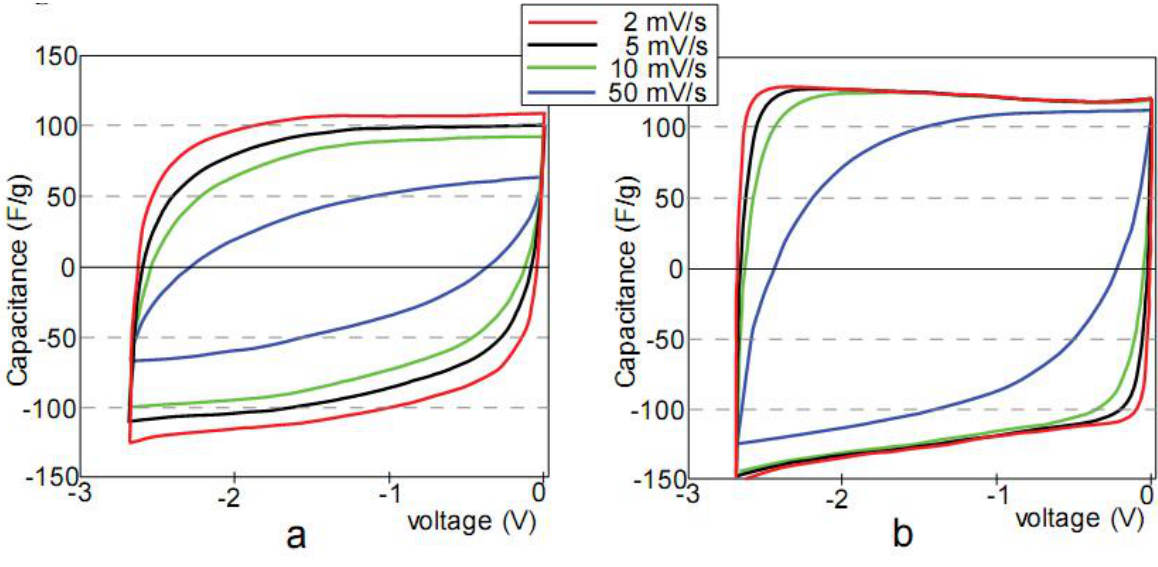
Figure 3. Capacitance vs . voltage of the actuators EMI600 (a) and EMI800 (b) at different voltage sweep